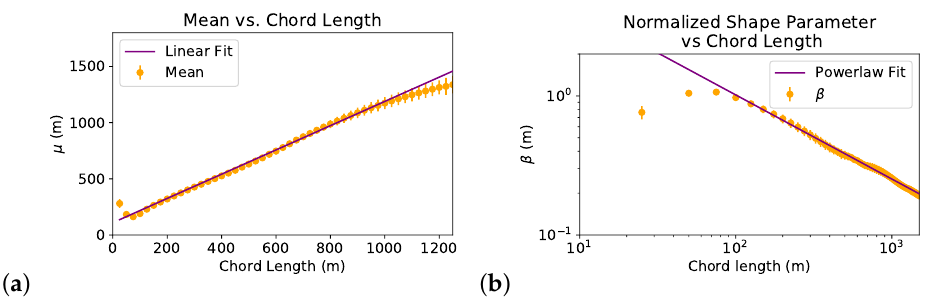
Figure 7. Fitting parameters of the gamma distribution, as a function of chord length. The vertical lines depict the standard deviation between different cases. ( a ) The mean µ . ( b ) The shape parameter β